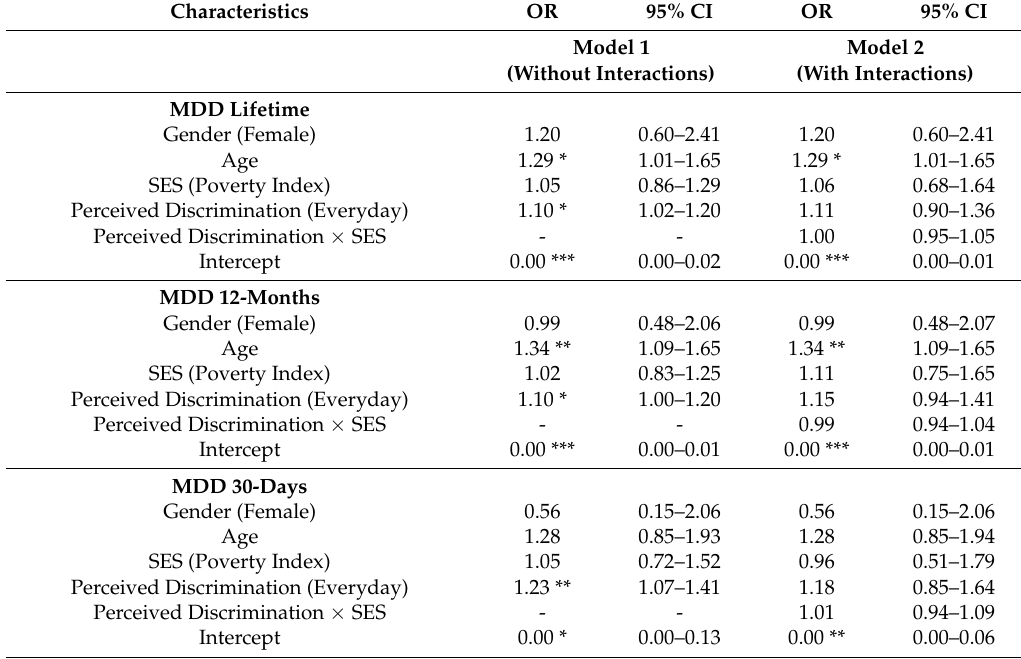
Table 4. Summary of logistic regressions on the multiplicative effects of perceived discrimination and poverty index on MDD ( n = 810).